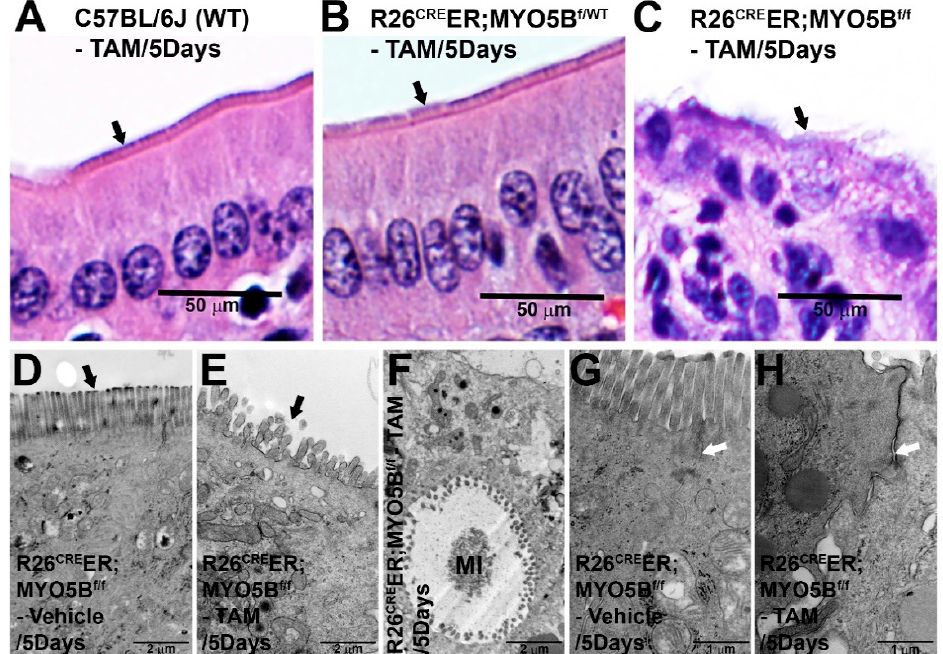
Figure 3. Histologic and ultrastructural changes in villus enterocytes of the small intestine induced by loss of MYO5B expression at day 5 of tamoxifen injection. H&E ( A – C ) staining of jejunum ( A ) C57BL/6J (WT), ( B ) R26 Cre ER;MYO5B f/wt (Heterozygous), and ( C ) R26 Cre ER;MYO5B f/f (Homozygous) mice treated with tamoxifen (2 mg/day/mouse) for 5 days. Shorter, aberrant microvilli (arrows) are observed in the tamoxifen-treated homozygous mouse jejunum compared to WT and heterozygous mice. Scale bars: 50 µ m. ( D – H ) Transmission electron micrographs (TEM) show ultrastructure of microvilli, microvillus inclusion (MI), and tight-junction (TJ) in villus enterocytes from R26 cre ER;MYO5B f/f mice treated with vehicle (corn oil) or tamoxifen (2 mg/day/mouse) for 5 days. ( D ) Vehicle-treated R26 Cre ER;MYO5B f/f mouse jejunum display long, uniform microvilli on the apical surface of the enterocyte (arrow). Scale bar: 2 µ m. ( E ) Tamoxifen-treated R26 Cre ER;MYO5B f/f mouse jejunum display shortened, disorganized, apical microvilli (arrow). Scale bar: 2 µ m. ( F ) Microvillus inclusion (MI) typical of MVID is detected in the tamoxifen-treated R26 Cre ER;MYO5B f/f mouse jejunal villus enterocytes. Scale bar: 2 µ m. ( G ) TJ (arrow) in vehicle-treated R26 Cre ER;MYO5B f/f mouse jejunal enterocytes. Scale bar: 1 µ m. ( H ) TJ (arrow) in the tamoxifen-treated R26 Cre ER;MYO5B f/f mouse jejunal enterocytes. Image shows distended, widened inter-enterocyte spaces and prominent TJ compared to vehicle-treated R26 Cre ER;MYO5B f/f mouse jejunal enterocytes. Scale bar: 1 µ